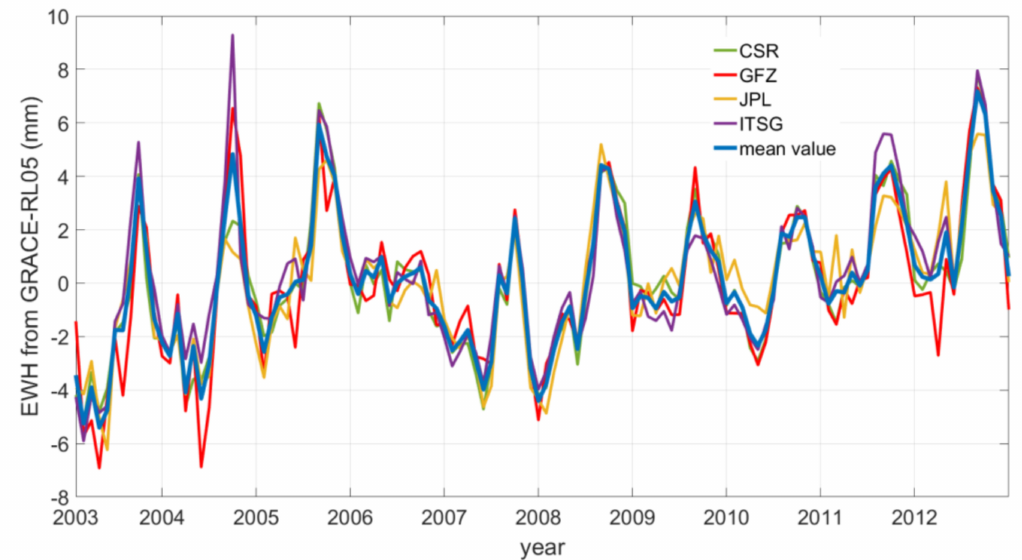
Figure 2. Time series of GRACE Level-2 Release 05 equivalent water height of YRSR from di ff erent institutions and their